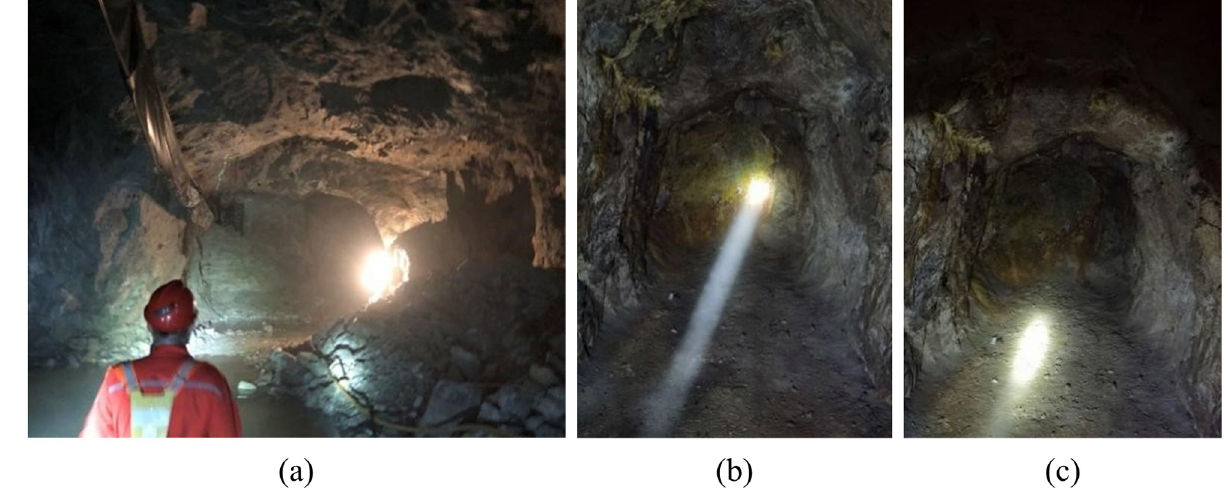
Fig 15. Stope investigation (a)Stope investigation; (b)Work face of three-layer; (c)Work face of four-layer.